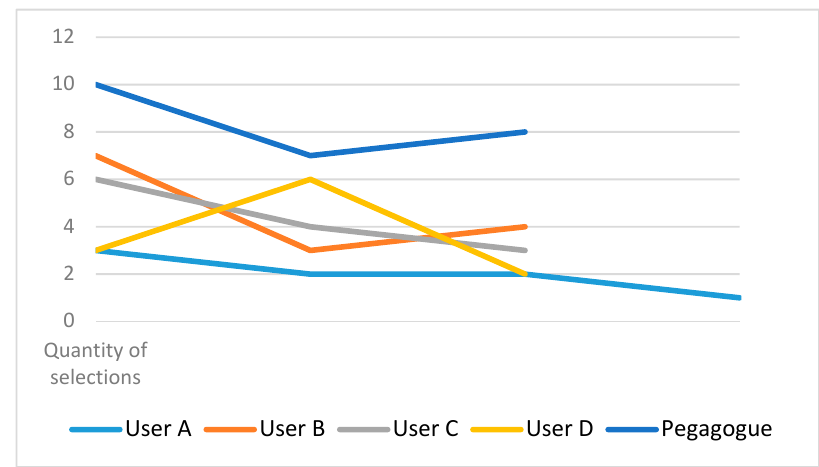
Figure 5. Users interacting with the system. (The y-axis represents the number of letters that each user selected in each experiment. The x-axis represents the particular session.)